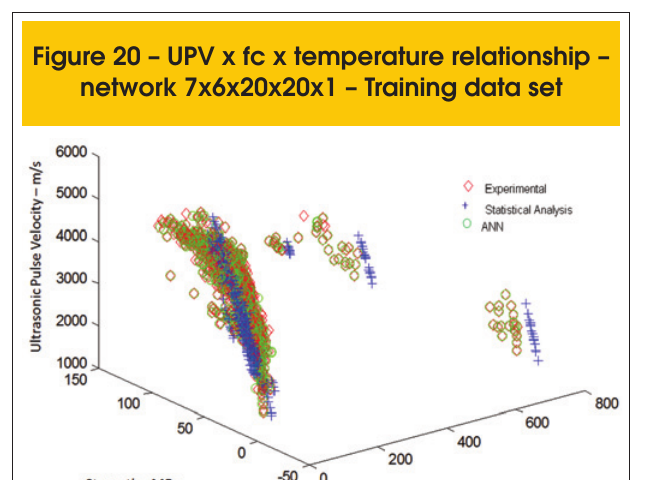
Figure 22 – UPV x fc relationship – network 7x8x20x20x1 – Training data set